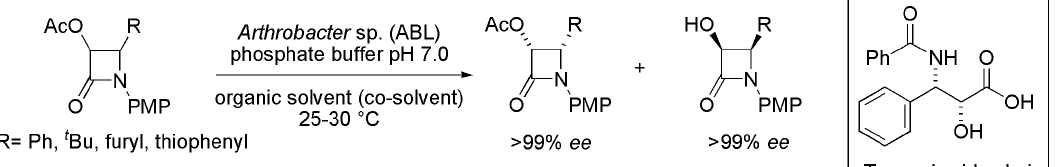
Scheme 1. Kinetic enzymatic hydrolysis of racemic arylazetidiones, precursors of amino acid